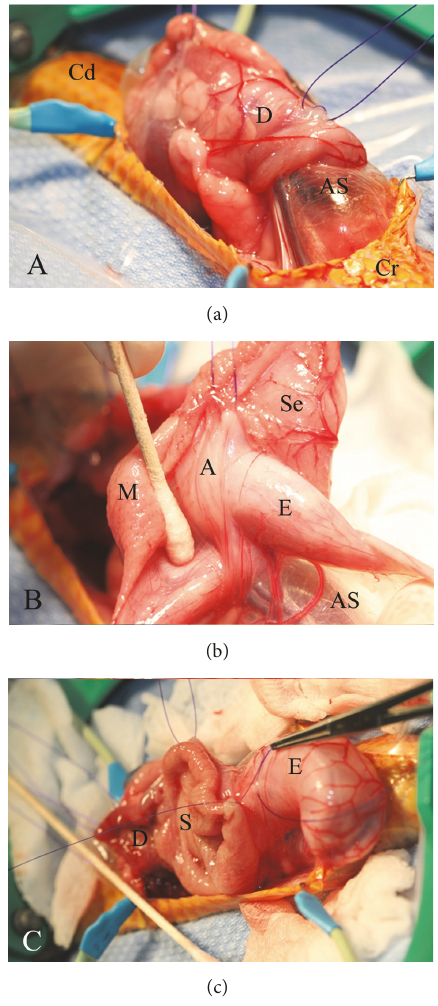
Figure 2: (a) Gastroduodenal intussusception. The duodenum (D) and air sac (AS) are readily visible at the surgical site. The cranial (Cr) and caudal (Cd) directions of the snake are identified. (b) Esophagogastric intussusception. After the gastrotomy, adhesions (A) are identified between the esophagus (E) and the stomach’s serosa (Se). The hypertrophied gastric mucosa (M) is visible. (c) Reduction of the double compounded intussusception. Depicted here are the esophagus (E), stomach (S), and duodenum (D) in their normal anatomic position.